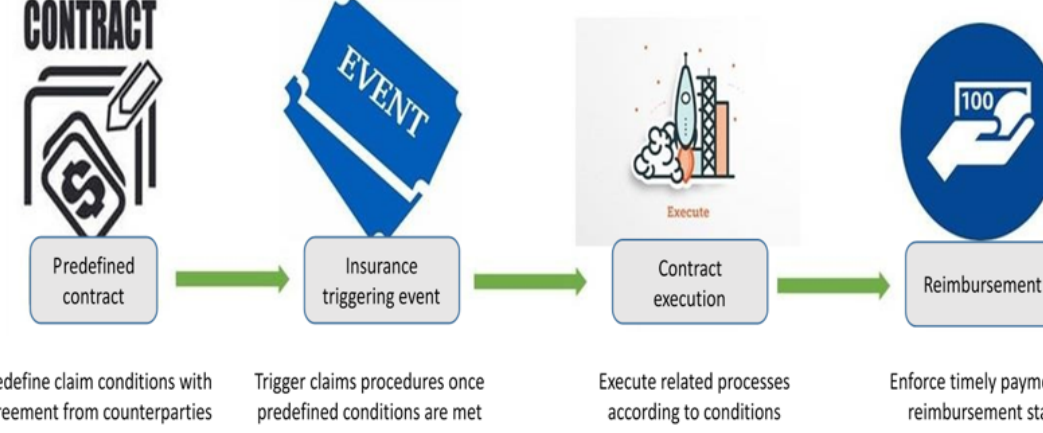
Figure 5. Framework of the smart contract–enabled insurance claims